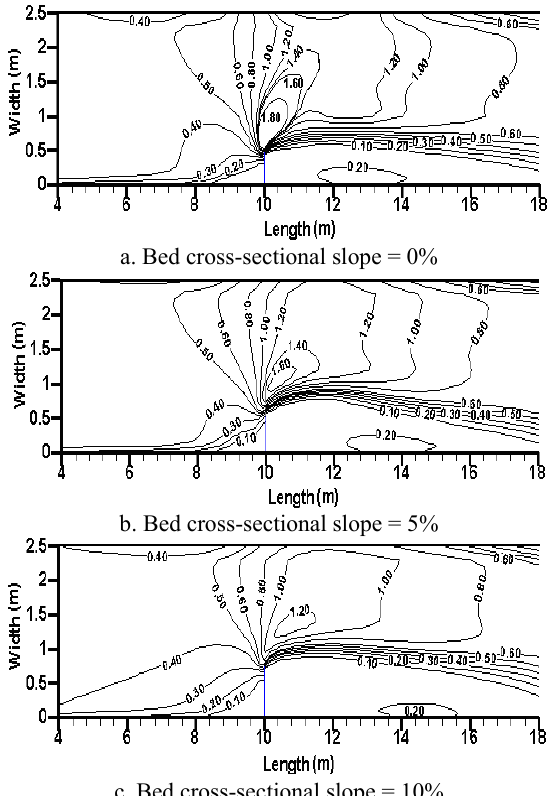
Fig.11 Isolines of bed shear stresses for the vertical groyne